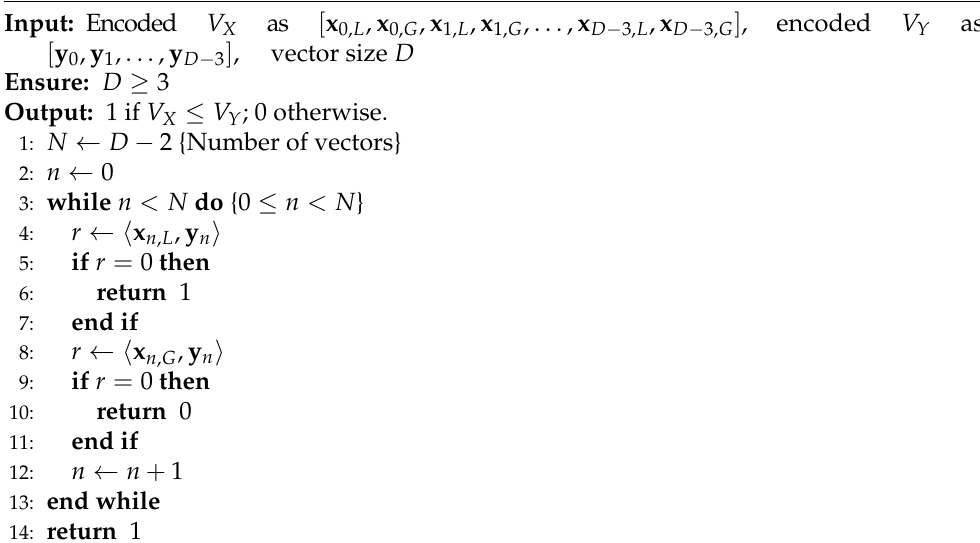
Algorithm 4 Comparison of two values encoded in two input vectors